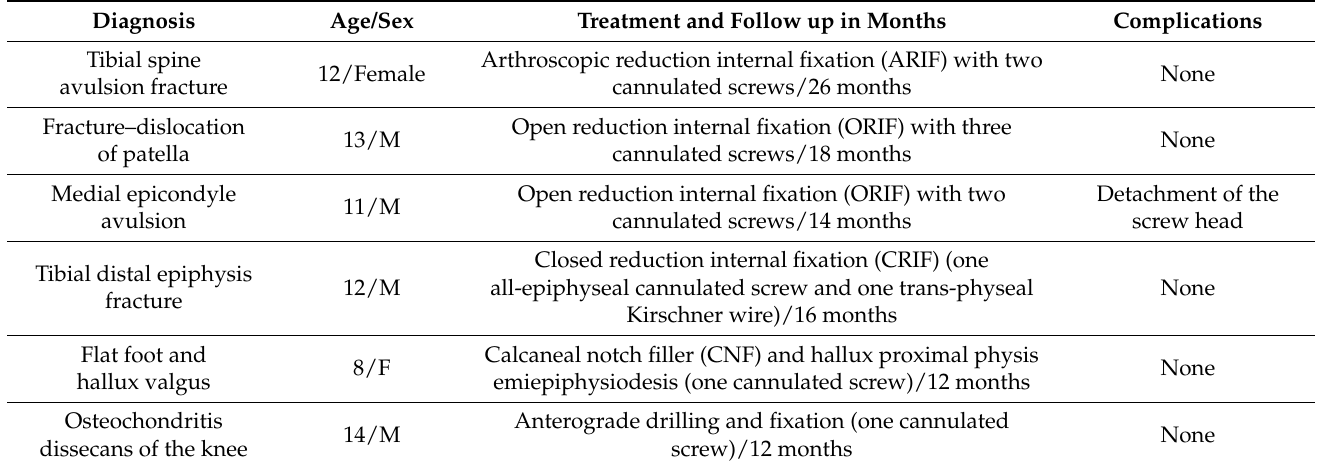
Table 1. Children cases with different fractures and treatments based on resorbable MAGNEZIX ® screws